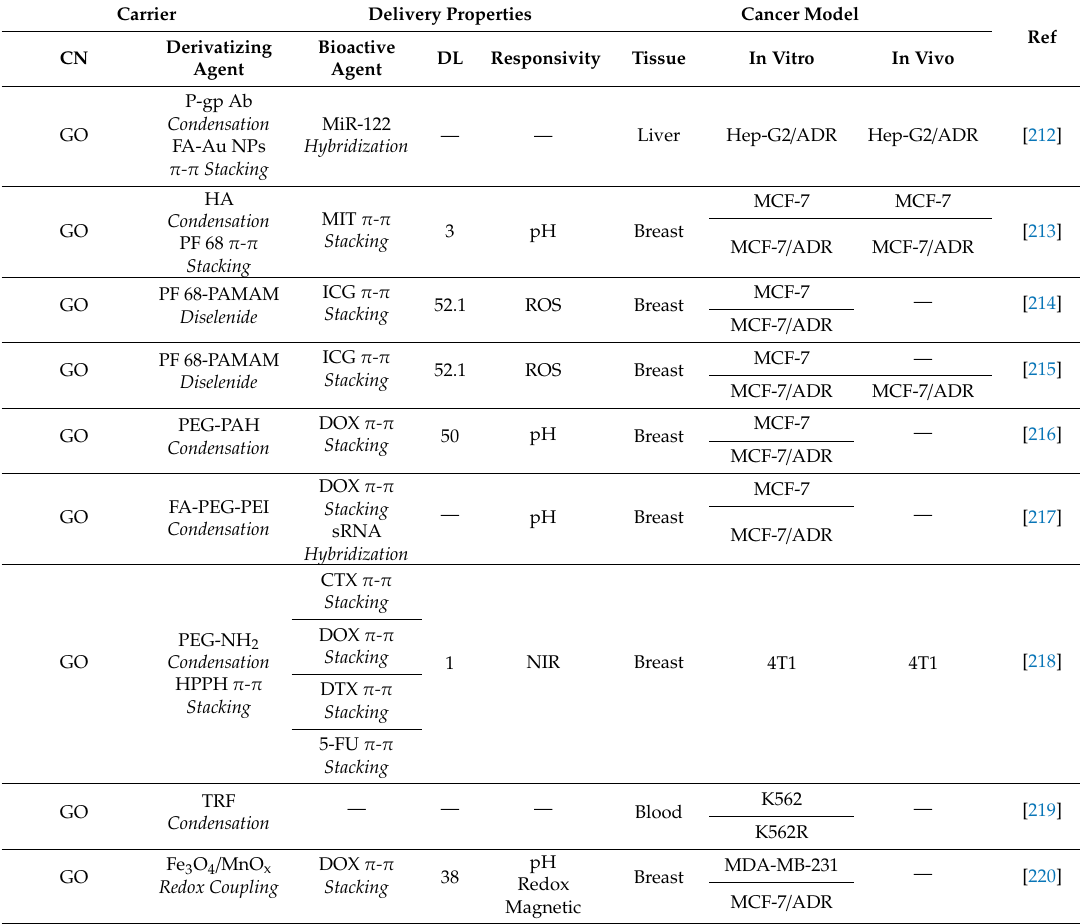
5-FU: fluorouracil; Ab: antibody; CTX: cyclophosphamide; DOX: doxorubicin; DTX: docetaxel; FA: folic acid; GO: graphene oxide; HA: hyaluronic acid, HPPH: 2-(1-hexyloxyethyl)-2-devinyl pyropheophorbide a; ICG: indocyanine green; MIT: mitoxantrone; NPs: nanoparticles; PAH: poly(allylamine hydrochloride); PAMAM: polyamidoamine; PEG: polyethylene glycol; PEI: polyethylenimine; PF: Pluronic F; TRF: